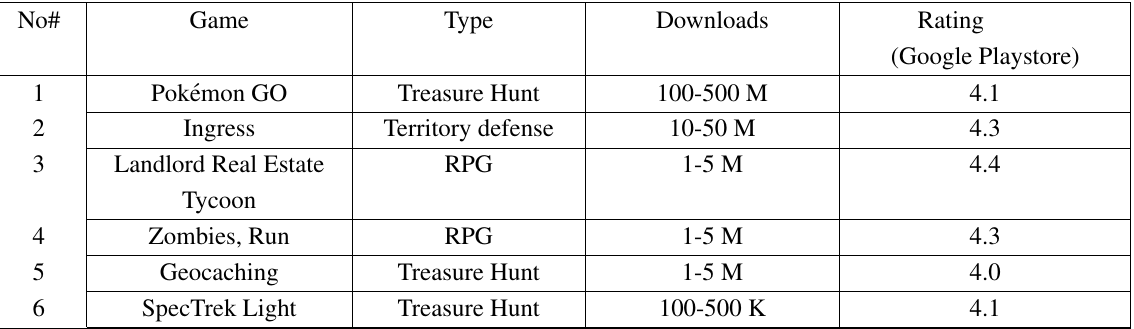
Table 1. List of pervasive games on Google